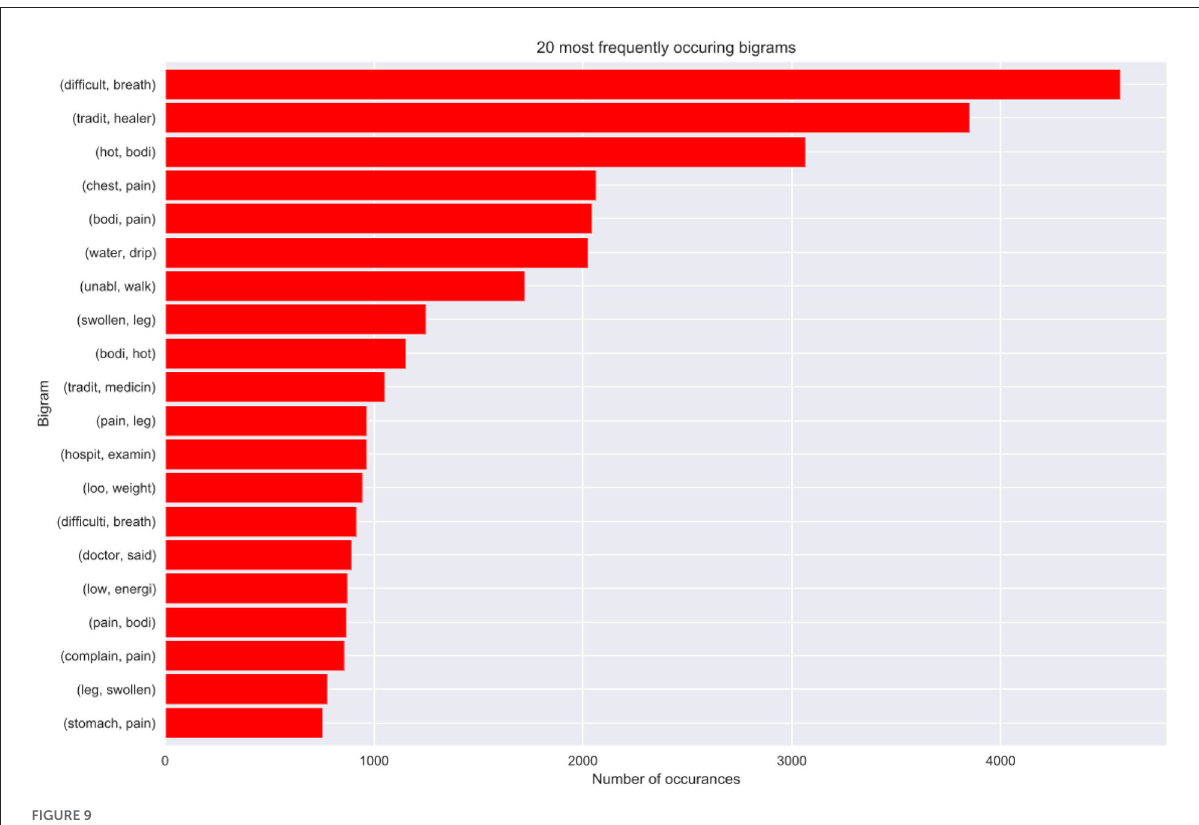
FIGURE9 Bi-gram model of our best model